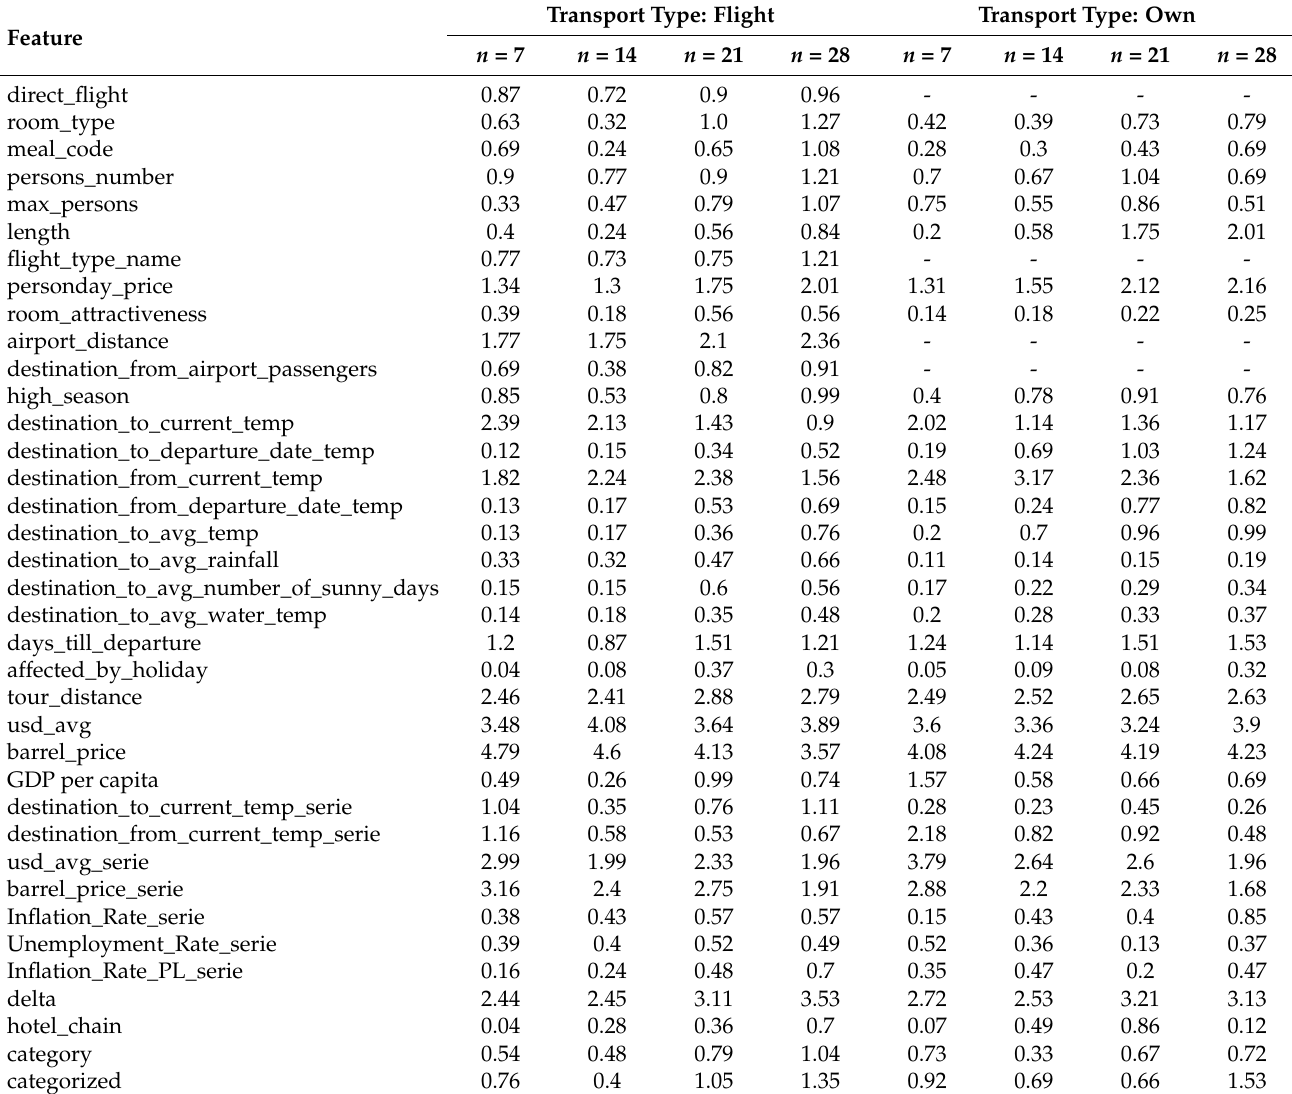
Table A1. Features’ weights assigned for four classification problems and two types of